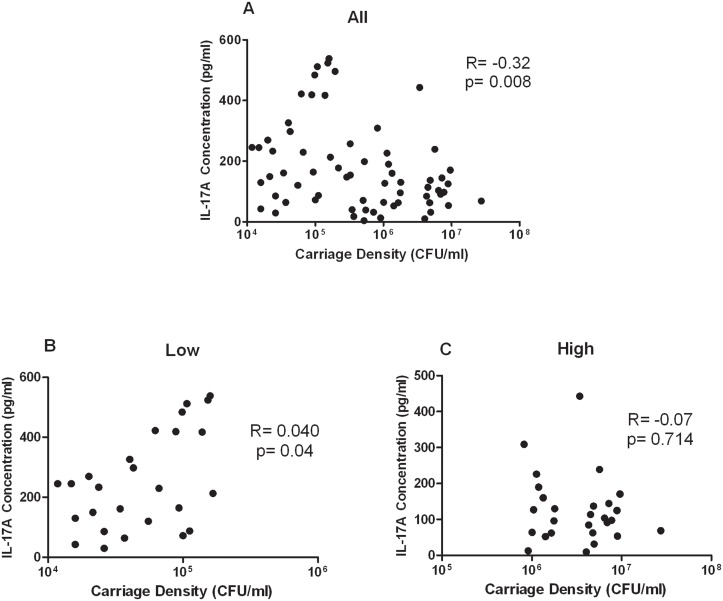
Relationship between pneumococcal carriage densities and IL-17A levels (A) Pneumococcal nasopharyngeal (NP) carriage densities in all 65 children from Fiji was measured by qPCR.IL-17A was measured by multiplex bead array. One child was removed from the analysis as an outlier (Carriage density = 1.65x105 CFU/ml, IL-17A = 1710pg/ml). The correlation with the outlier was R = -0.19, p = 0.126. Correlation between IL-17A and children with low pneumococcal carriage density (B; N = 27) or children with high pneumococcal carriage density (C; N = 27). The Spearman test was used to correlate children with pneumococcal carriage density and IL-17A levels.